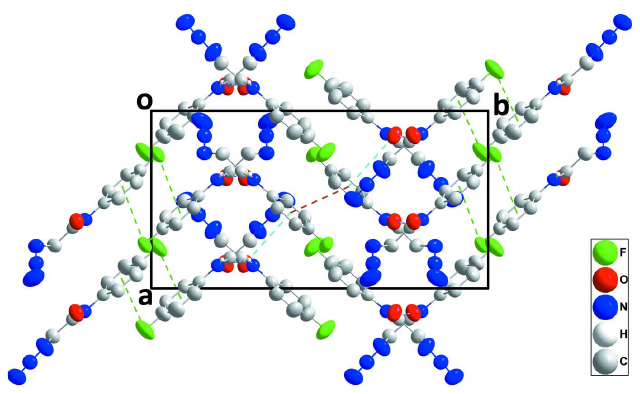
Figure 4 Packing viewed along the c -axis direction showing the linking of chains via C—F (cid:2)(cid:2)(cid:2) (cid:2) (ring) (green dashed lines) and C15 O2 (cid:2)(cid:2)(cid:2) Cg 1 (light-blue dashed lines) and slipped (cid:2) -stacking (orange dashed lines) interactions. N—H (cid:2)(cid:2)(cid:2) O hydrogen bonds and non-interacting hydrogen atoms are omitted for clarity.